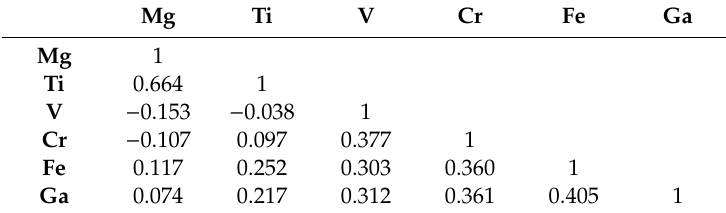
Table 8. Correlation table for trace elements of secondary Montana blue / green and pink sapphires and rubies. Mg